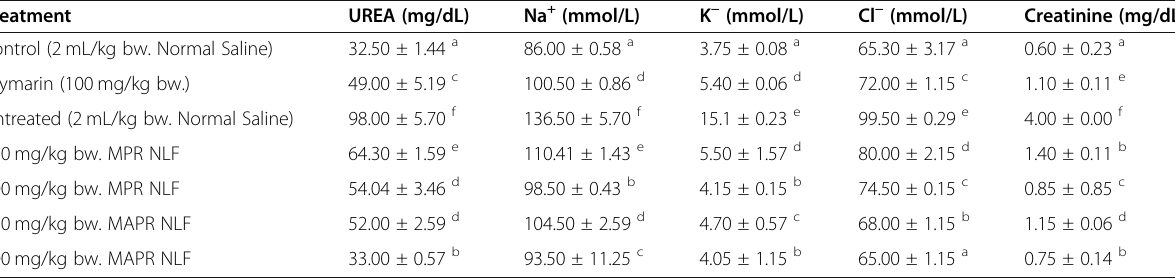
Table 7 Kidney damage biomarkers of male Wistar rats administered with lead acetate and treated with methanol and methanol/ acetone phenolic-rich extracts of N. latifolia fruit Treatment Control (2 mL/kg bw. Normal Saline) Silymarin (100 mg/kg